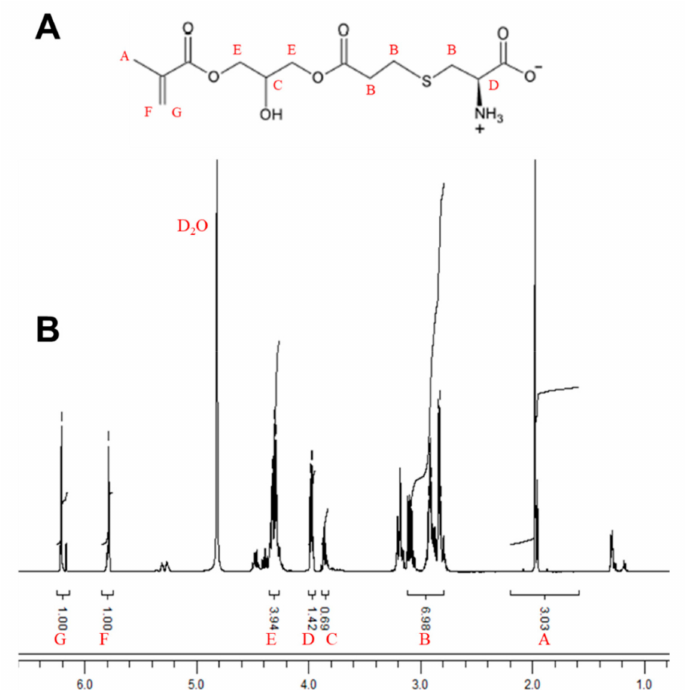
Figure 1. 1 H-NMR analysis of CysMA (500 MHz). The CysMA monomer was synthesized using a selective Thia–Michael addition in an aqueous solution at 20 ◦ C. ( A ) CysMA structure. ( B ) The CysMA 1 H-NMR spectra. (400.13 MHz, D δ (ppm): [A] 1.89 (s, 3H, -CH 2 O, 298 K) 3 ); [B] 2.68–3.17 (m, 6H, -S-CH 2 -CH 2 -COO-, -S-CH 2 -CH(COO - )NH 3 + ); [C] 3.79 (m, IH, CHOH); [D] 3.90 (m, 1H, -CH(COO-) NH 3 + ); [E] 4.20–4.30 (m, 4H, -CH 2 -CHOH-CH 2 -); [F] 5.70 (s, 1H, vinyl); and [G] 6.13 (s 1H,